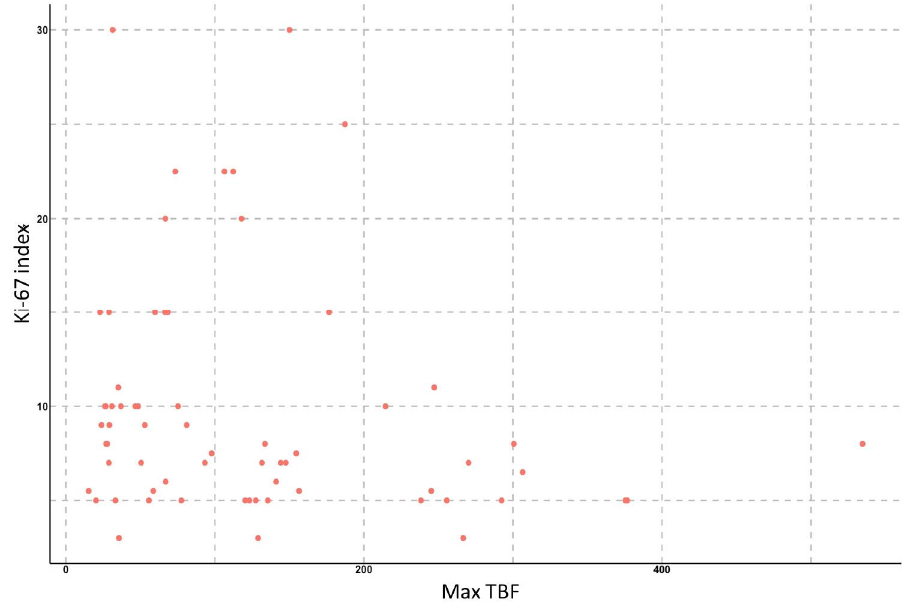
Figure 6. Scatterplot demonstrating the relationship between maximum TBF in gliomas of various grades and Ki-67 index.